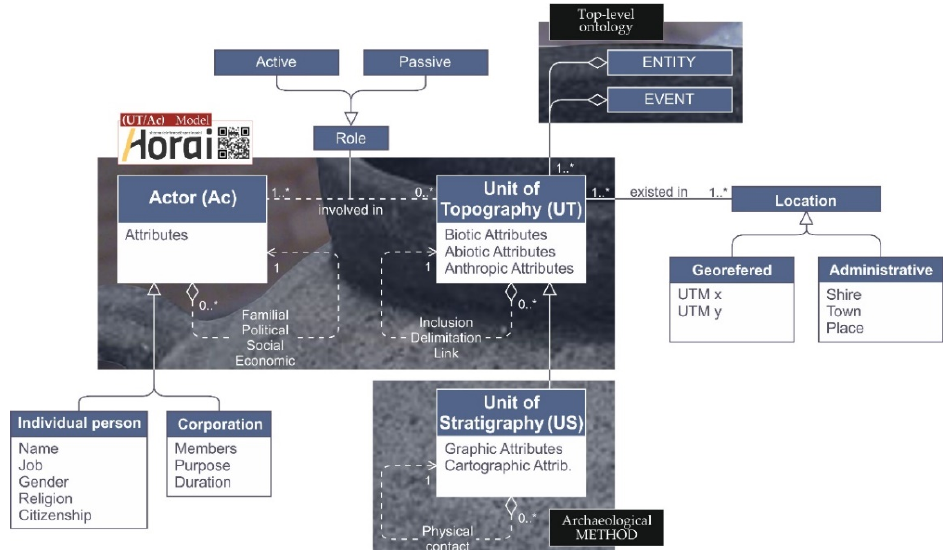
Figure 2. UML diagram of ontological concepts—UT, US, Ac and their relations—for integrated historical research according to the H ORAI model, after [18]. Commitment of this model to further top-level ontologies, such as those proposing the adoption of Entity and Event categories [10,35,36] or the commitment of the archaeological method represented by the class ‘Unit of Stratigraphy’ as proposed by E.C. Harris [41], are specified.